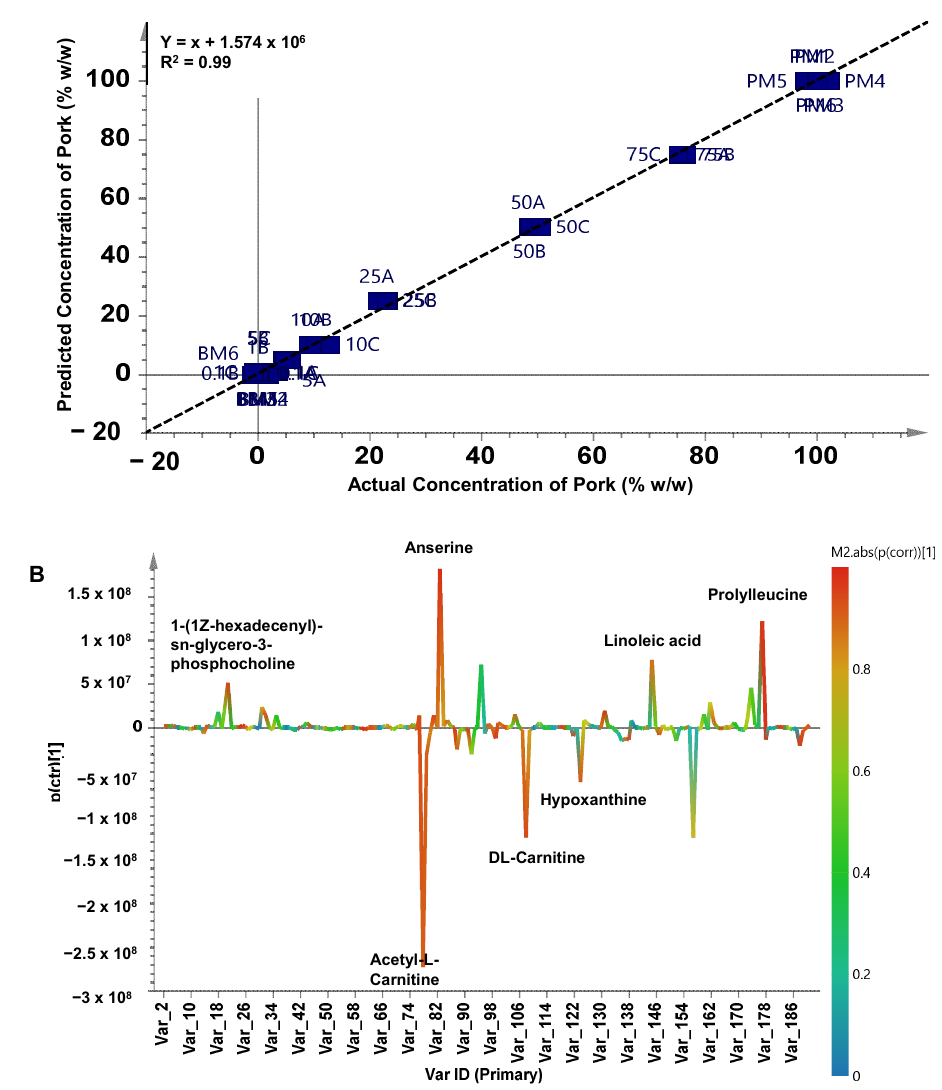
Figure 4. Orthogonal PLS plot ( A ) and S-line plot ( B ) to predict the concentration of pork in beef meatballs.